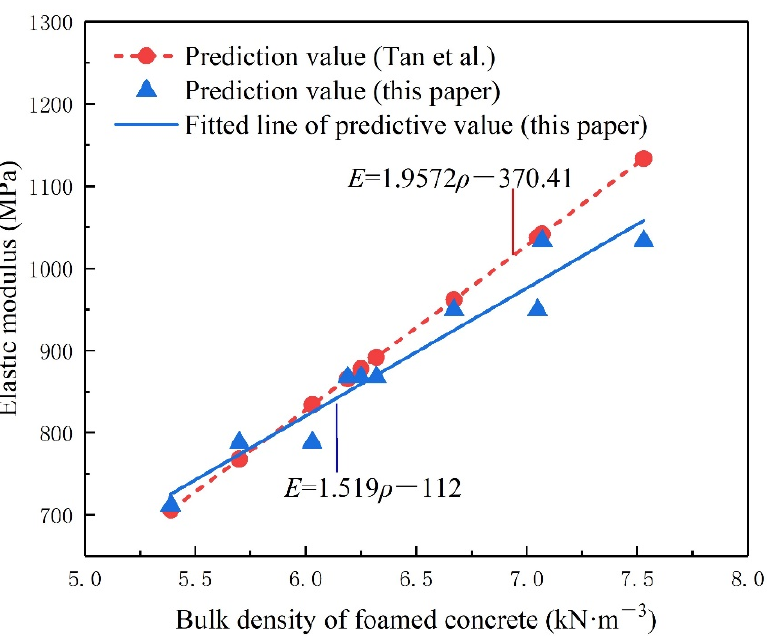
Figure 10. Comparison between the elastic modulus theory of foamed concrete and existing research